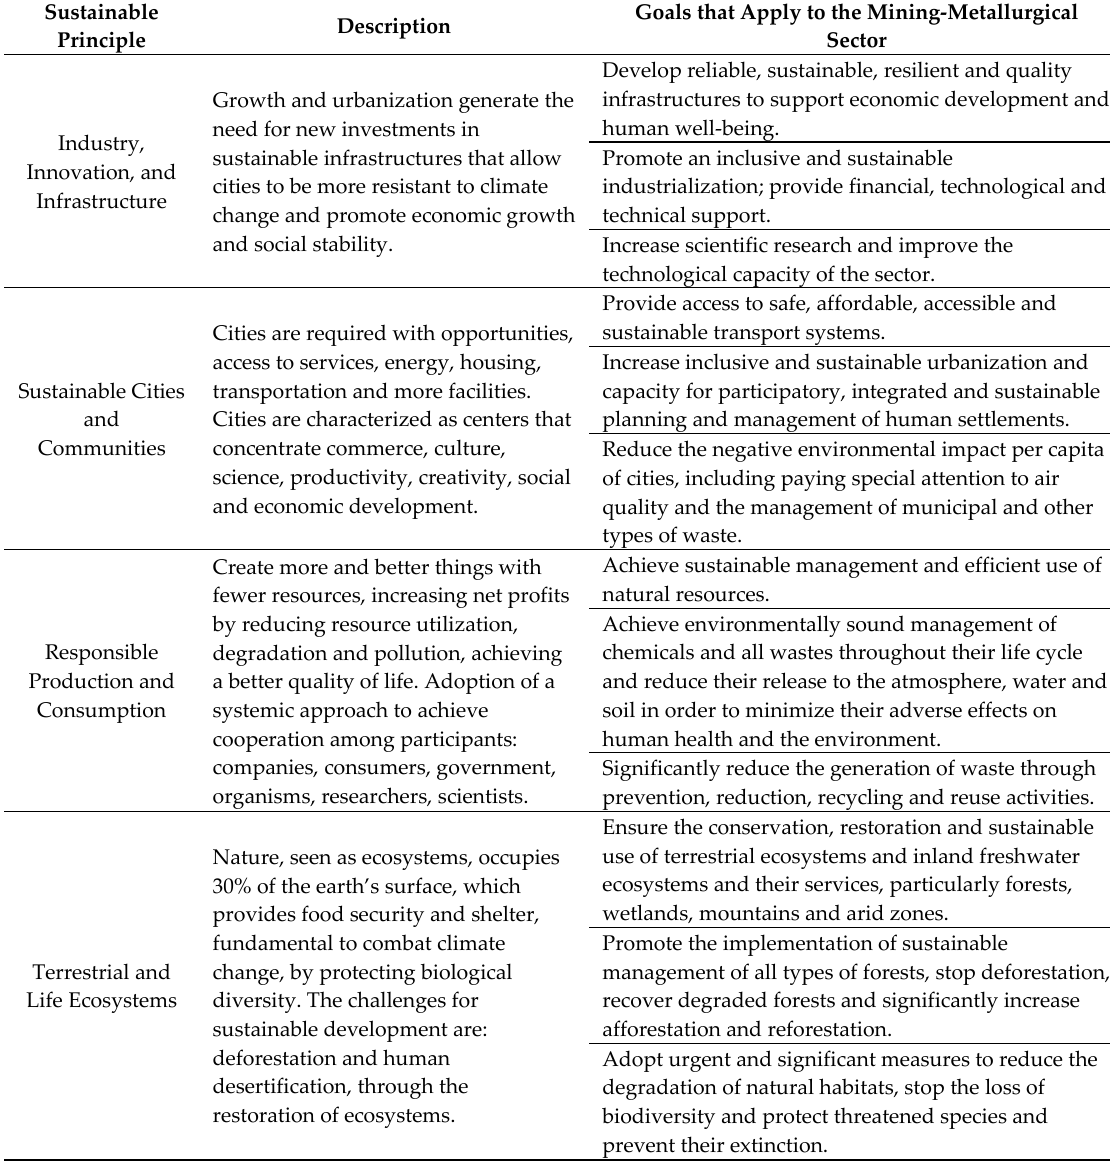
Table 1. Relationship of objectives of sustainable development and operating process of the mining- metallurgical sector. Source: own